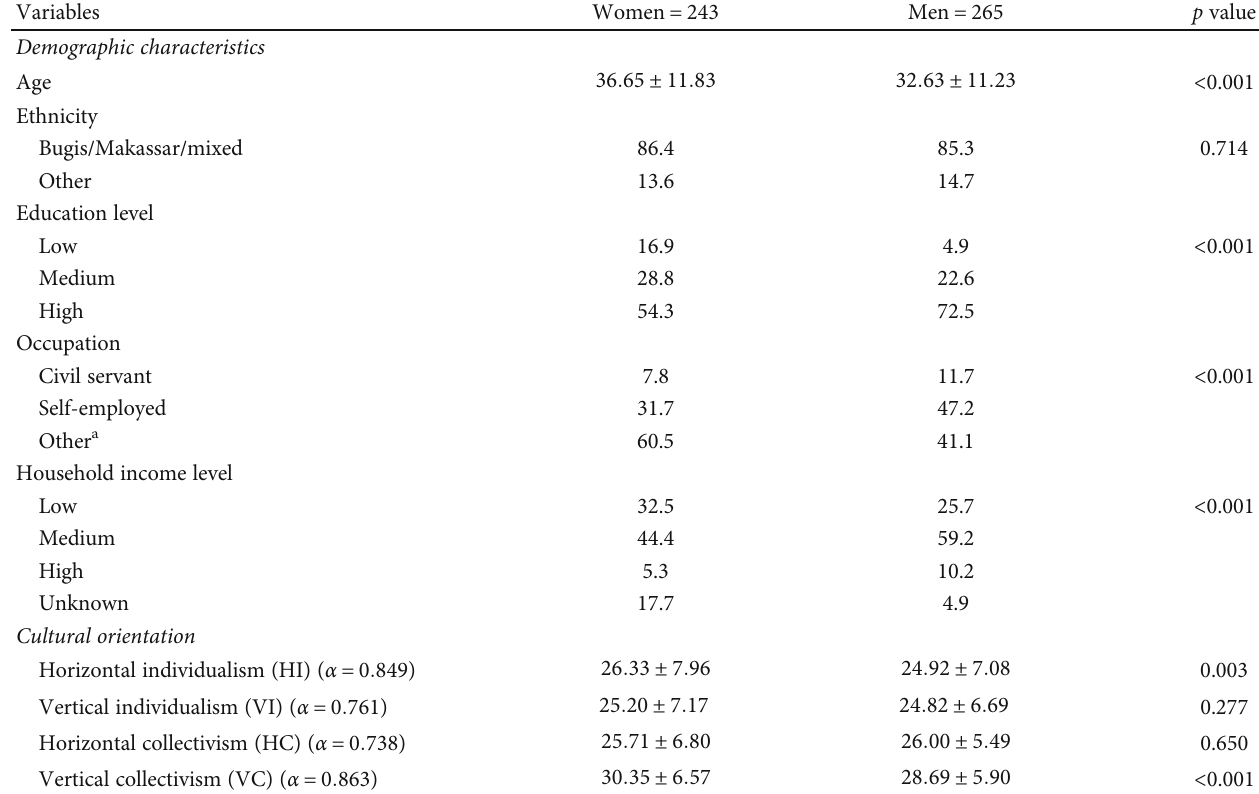
Table 1: Demographic characteristics and cultural